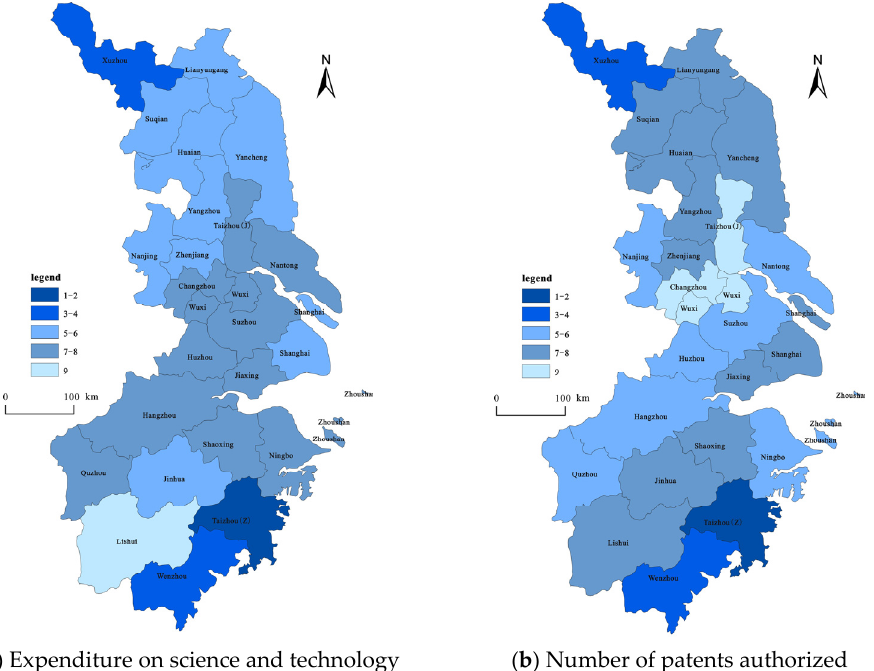
Figure 8. Spatial pattern of gray correlation degree ranking between technological innovation and water pollution in the YRD.